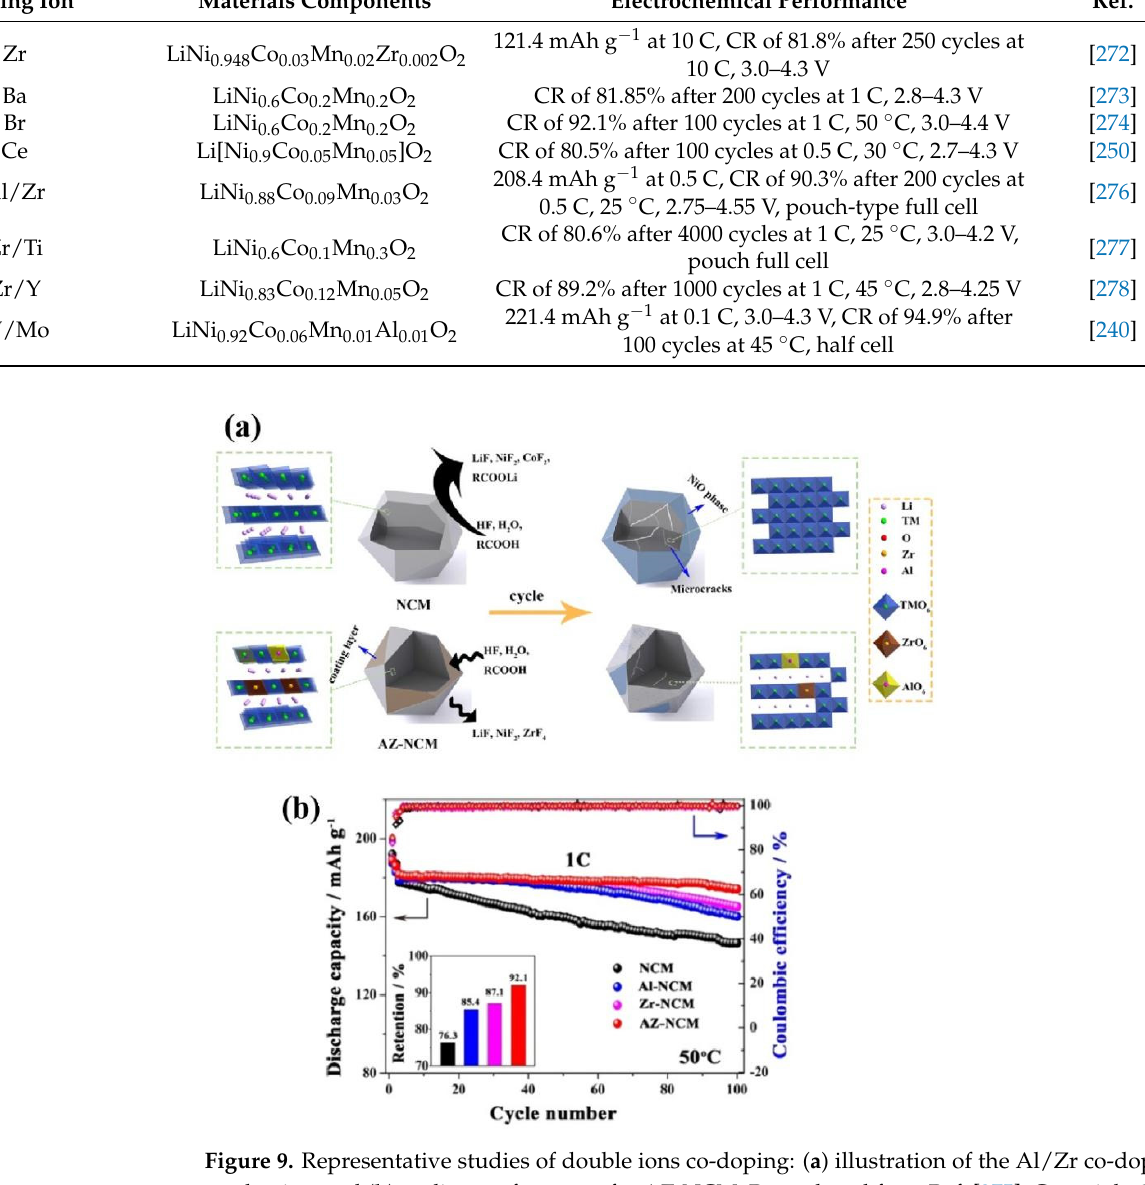
Table 2. Electrochemical properties of single-crystal nickel-rich NCM materials with different ion doping. (CR = Capacity Retention).